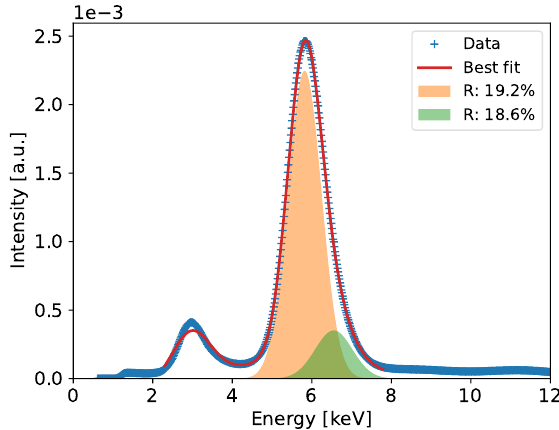
Figure 14. GEM detector C 2 . 55 Fe spectrum for detector bias voltage of 3840V.